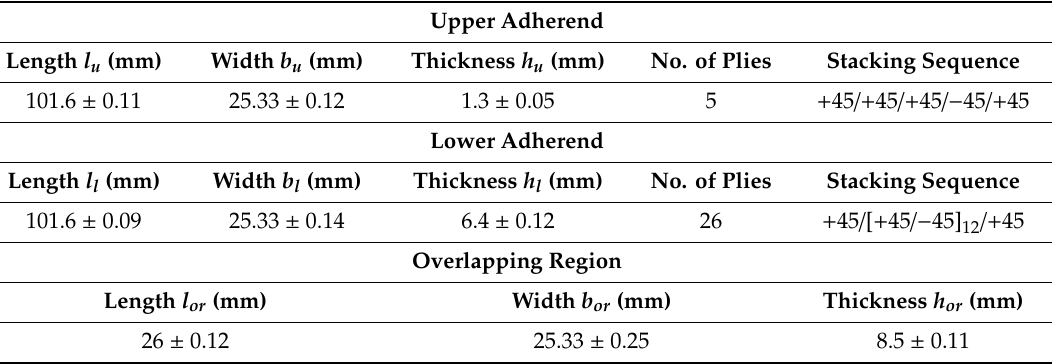
Table 2. Single Lap Shear (SLS) Specimen Nomenclature, Geometry and Configurations.